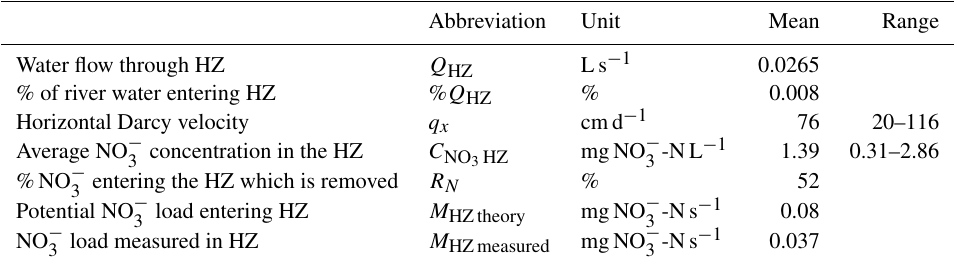
Table 3. Summarised parameters of NO − transport and removal through the upper 50cm of the hyporheic zone at the test site for the testing 3 phase from 4–11 June 2015. Ranges are indicated for directly measured parameters, the remaining parameters have been calculated from listed means.